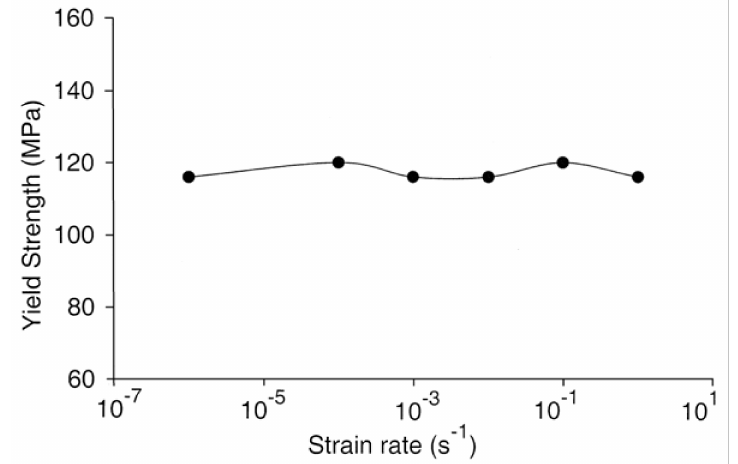
Figure 24. Variation in yield strength with strain rate for 6061 Al alloy in air at room temperature. Reprinted with permission from ref. [33]. Copyright 2001